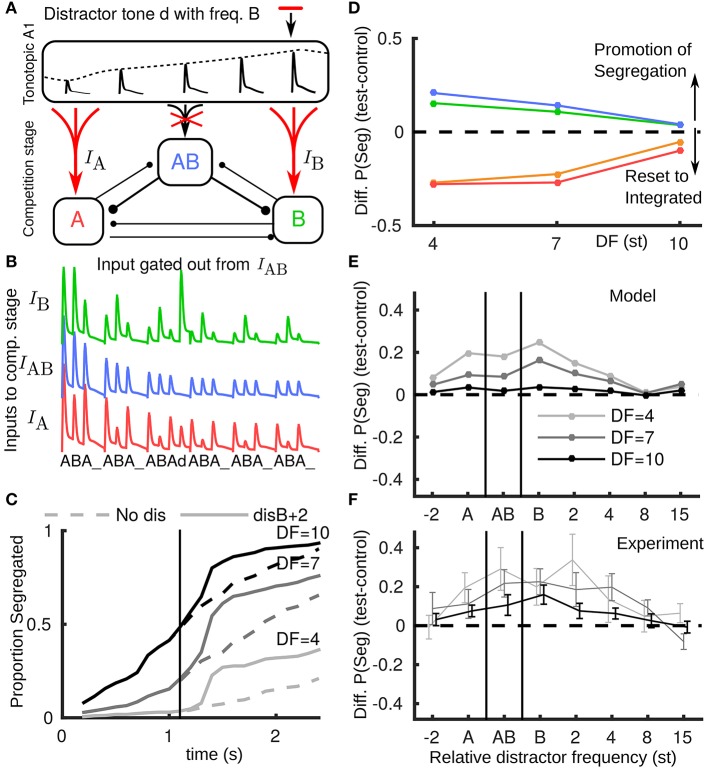
Non-triplet (deviant or distractor) tones are gated out from AB unit. (A) Schematic showing how a distractor d with, e.g., the frequency of a B tone, propagates in the model when boosted to A and B units and gated out from the AB unit. (B) Model inputs from A1 with a distractor tone (at B+2) after the third triplet where it is not seen by the AB unit, contrast with Figure 3D. (C) Build-up function in this case shows that the distractor tone results in an immediate increase in segregation, contrast with Figure 3E. (D) Based on the new assumption the model captures, along with the resetting effects of pauses, the promotion of segregation for distractor and deviant tones, compare with Figure 2C (same color conventions). (E) The model predicts the largest effect for the distractor tone when it is close to the B location, that the effect is largest for small DF and that the effect diminishes if the distractor tone is too far above B or below A. Note x-axis does not have fixed spacing and distance between A and B changes with DF. (F) Experimental data showing promotion of segregation with respect to the tonotopic location of the distractor tone.